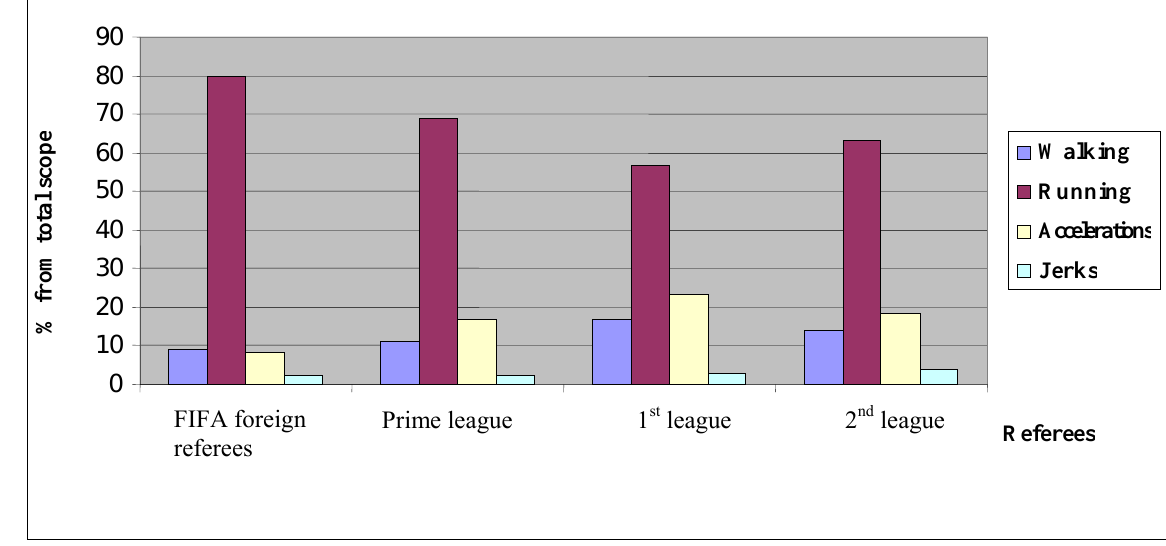
Fig.1.Comparison of mean indicators of professional football referees’ motion functioning in the course of different levels’